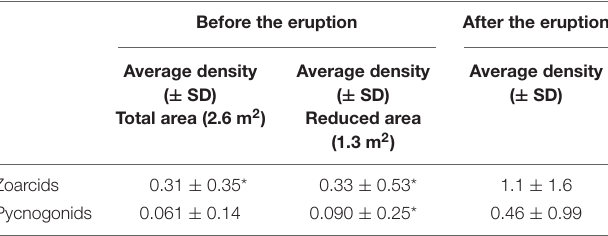
TABLE 3 | Average ( ± SD) densities (number of individuals per m 2 ) of zoarcids ( Lycodes squamiventer ) and pycnogonids ( Nymphon macronyx ) before and after the mud eruption.